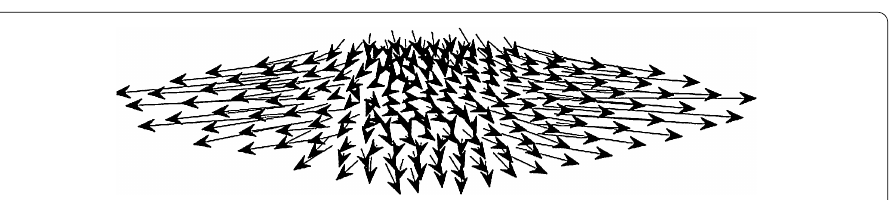
Figure 5 The ray mapping obtained by minimizing the Monge functional